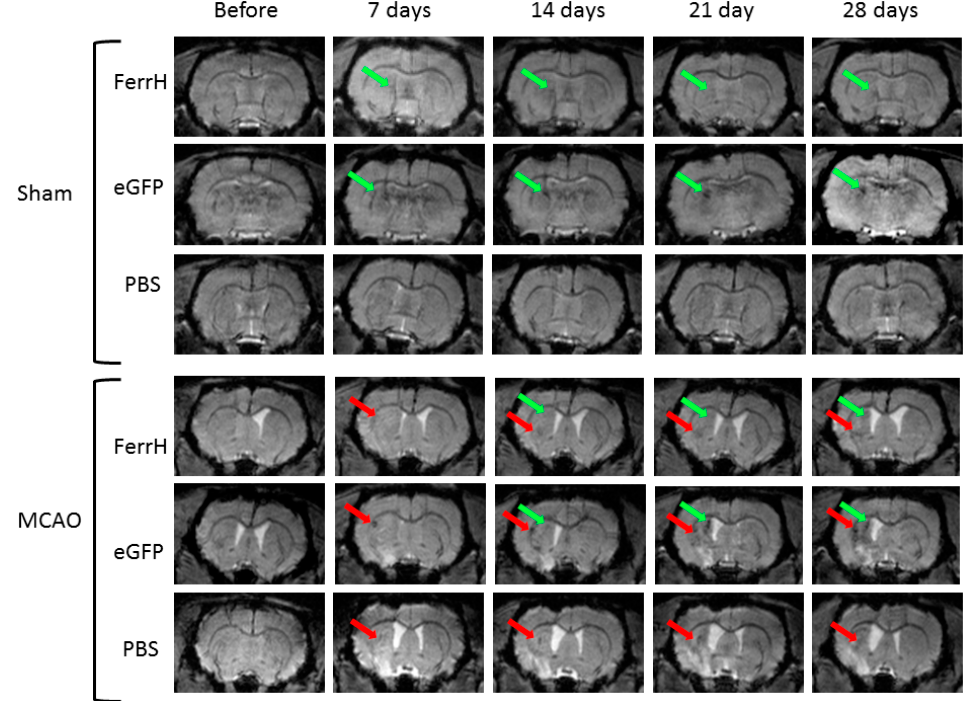
Figure 2. Evolution of the signal hypointensity zones detected in the rat brain in vivo before MCAO and on days 7, 14, 21, and 28 after injection of AAV-pDCX-FerrH, AAV-pDCX-eGFP or PBS using T2*-weighted MGE pulse sequence. Red arrows point to the signal hypointensity in the ischemic lesion area. Green arrows point to the signal hypointensity in the rat brain area close to the SVZ. Abbreviations: MCAO, middle-cerebral-artery occlusion; PBS, phosphate-buffered saline; AAV, adeno-associated viral backbone; pDCX, doublecortin promoter; FerrH, ferritin heavy chain; eGFP, enhanced green fluorescent protein.